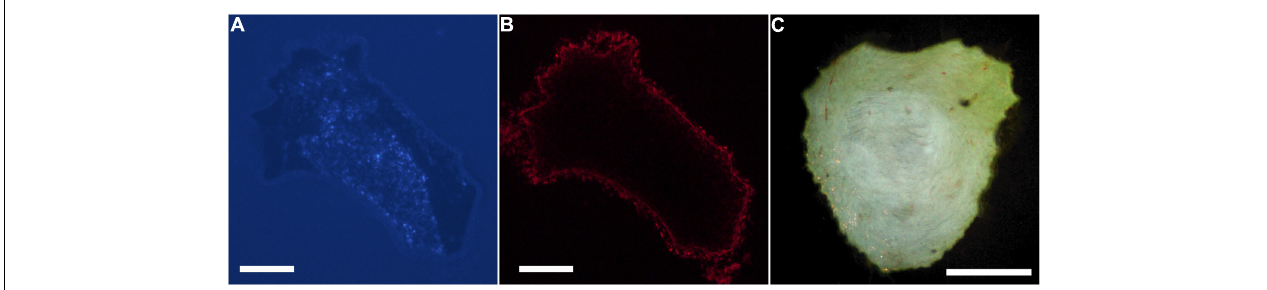
FIGURE 1 | Digital micrographs of a transverse section of a proximal segment of a sciatic nerve visualizing. (A) Fast Blue-labeled axons contributing to the tibial branch (DAPI filter), and (B) the same section visualizing propidium iodide staining for total nerve area (Texas Red filter). (C) Darkfield digital micrograph of a transverse section of a proximal segment of a sciatic nerve showing BHRP-labeled TA motoneurons. Scale bars = 250 µ